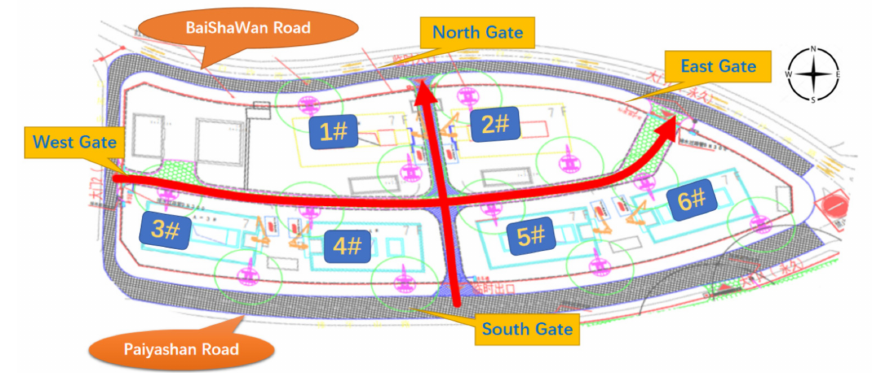
Figure 8. Traffic streamline planning in construction area A.